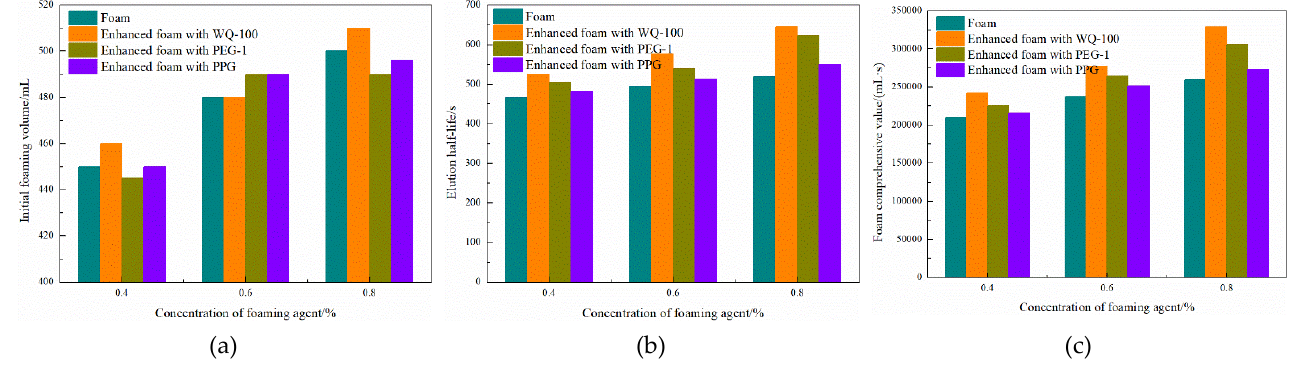
Figure 12. The basic performance of enhanced foam system and single foam: ( a ) foam volume, ( b ) foam liquid chromatography half-life, ( c ) foam composite value.